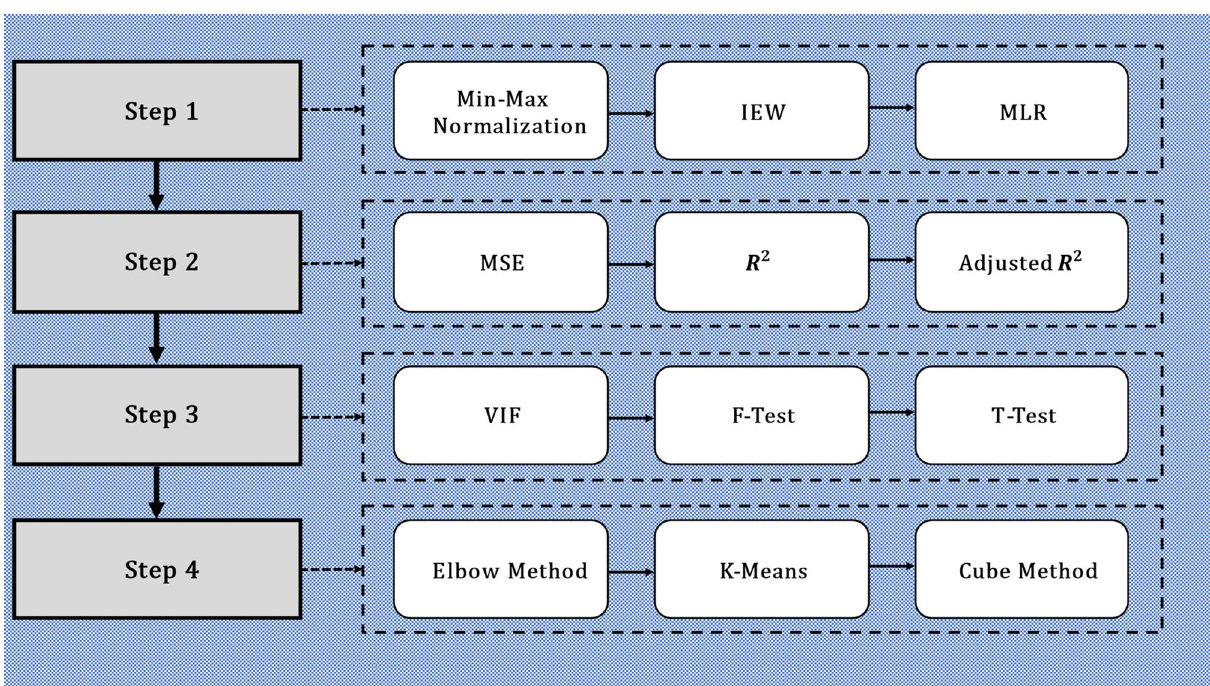
Figure 4. Research structure and applied